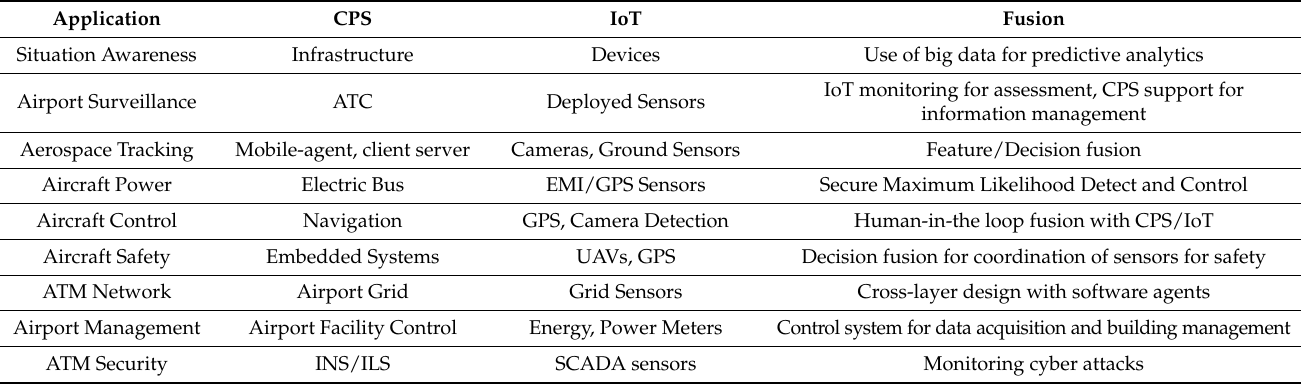
Table 4. Summary CPS constructs and methods in aviation.